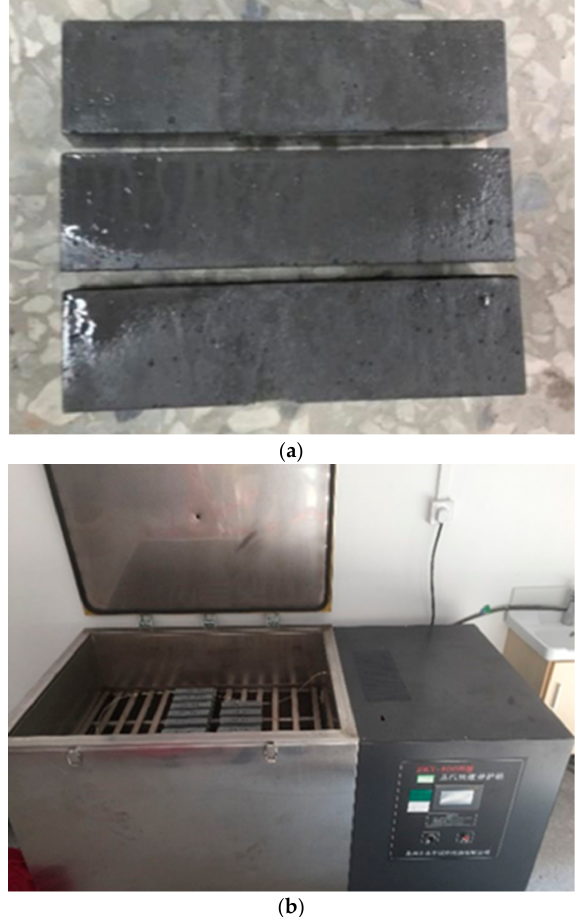
Figure 2. ( a ) Specimens for flexural strength test. ( b ) Specimens cured in a steam box.